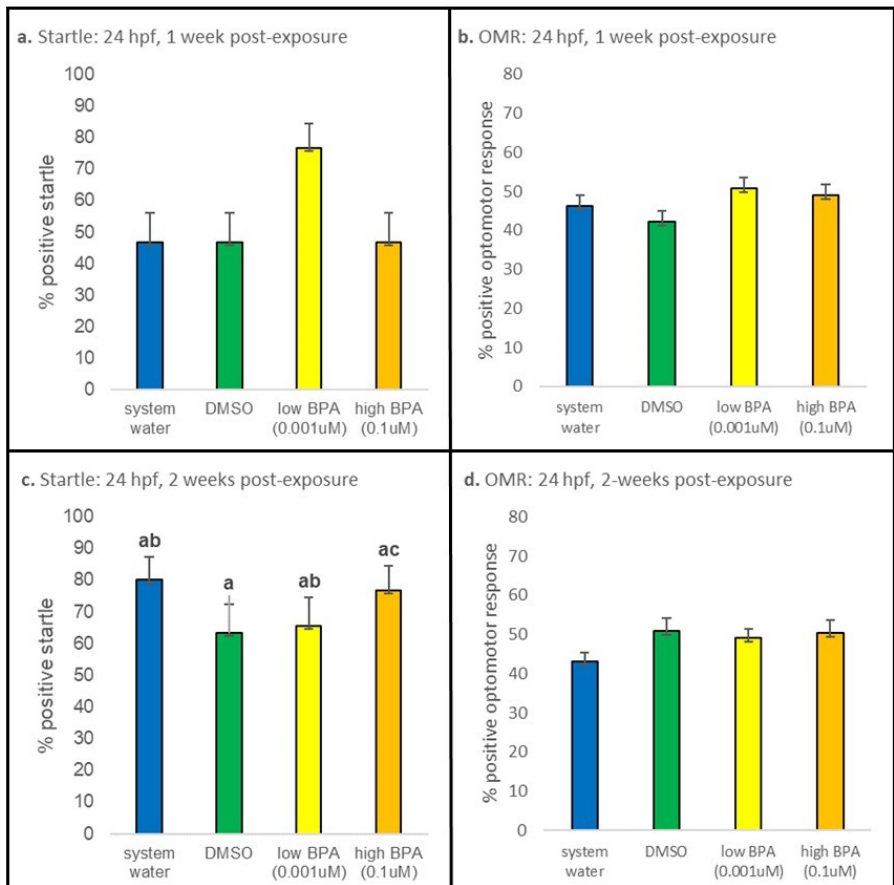
Figure 5. Twenty-four hours postfertilization behavioral results. ( a ) After 1 week of washout, larvae exposed at 24 hpf did not display statistically different startle responses. ( b ) No differences were noted in OMRs displayed by after 1 week of recovery. ( c ) At 2 weeks post-exposure, larvae exposed to high BPA displayed increased startle responses compared to larvae exposed to low BPA only ( p = 0.001). ( d ) No differences in OMRs were observed in larvae exposed at 24 hpf at the 2 week time point. At each recovery point n = 30 for all treatment groups. Startle responses were analyzed using a one- way ANOVA performed separately for each age and treatment group; if significance was noted, a Tukey post hoc test was performed to identify differences. OMR was analyzed using a one-way ANOVA, followed by a post hoc multiple com- parison (with a Bonferroni correction). All values are reported as mean ± SE. Different letters denote significance.